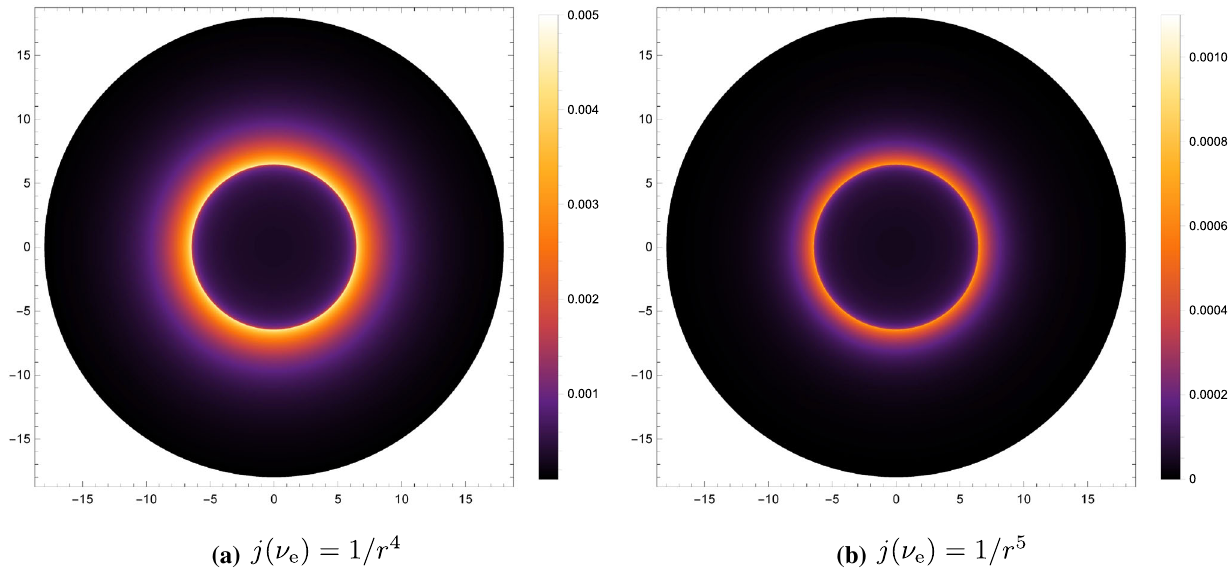
Fig. 7 Profile of the specific intensity I ( b ) seen by a distant observer with different profiles of specific emissivity. For both cases, we set M = 1, α = − 5 . 5